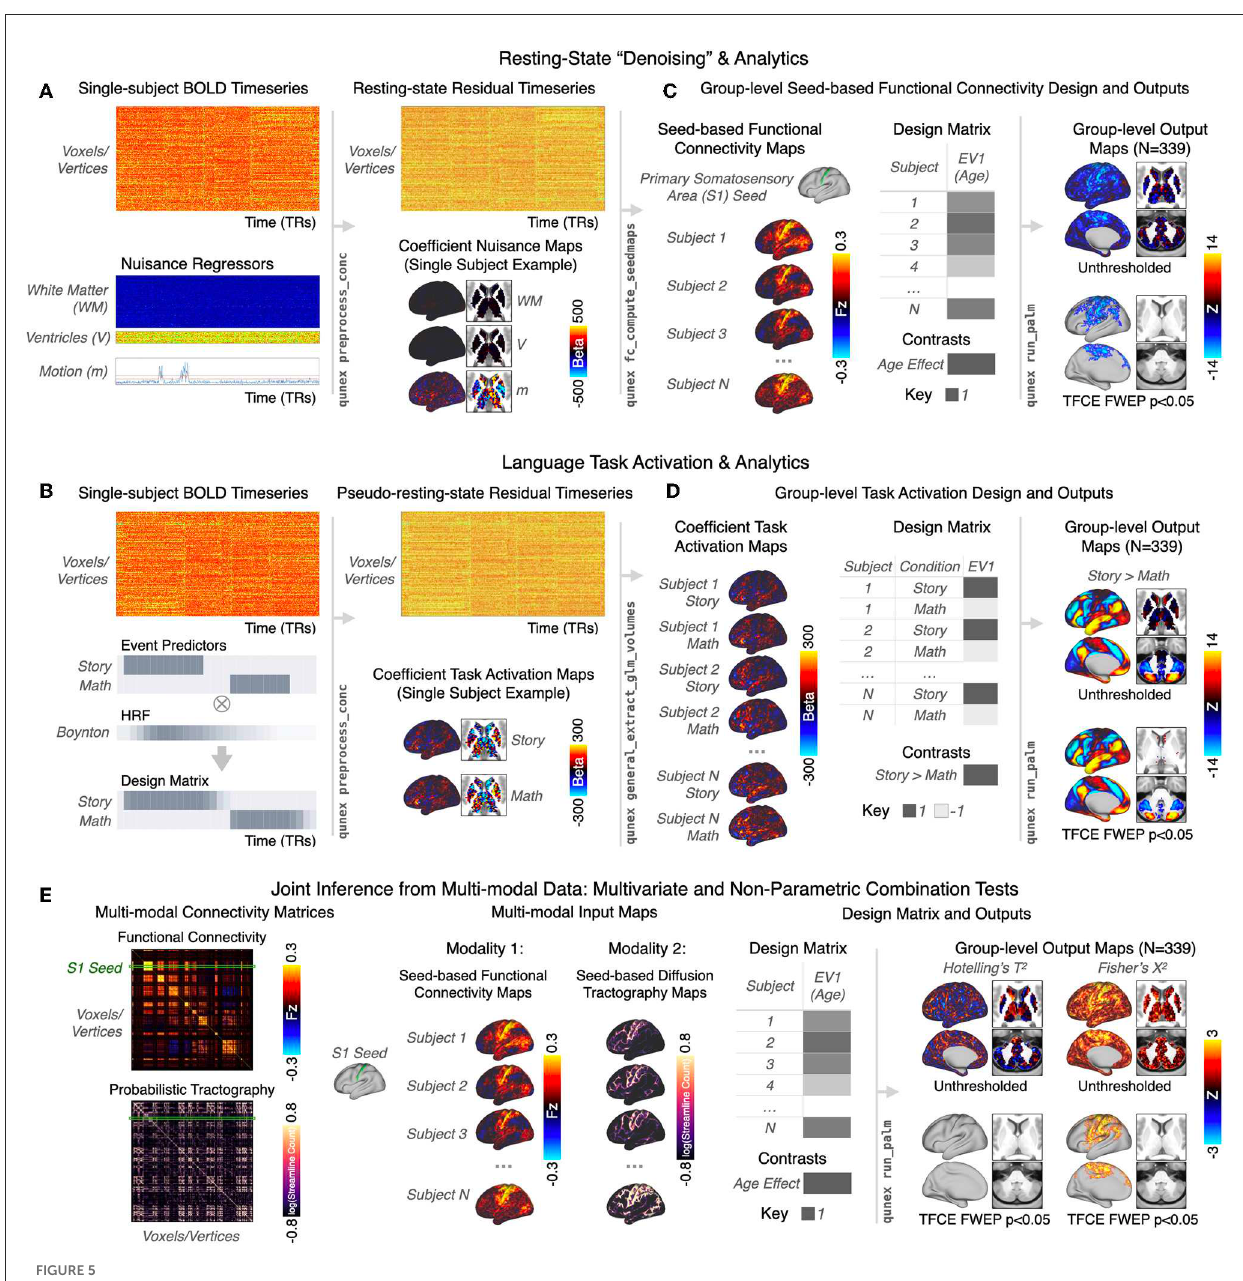
FIGURE5 General Linear Model (GLM) for single-session modeling of time-series modalities and integrated interoperability with PALM for group-level analytics. (A) The QuNex GLM framework enables denoising and/or event modeling of resting-state and task BOLD images at the individual-session level in